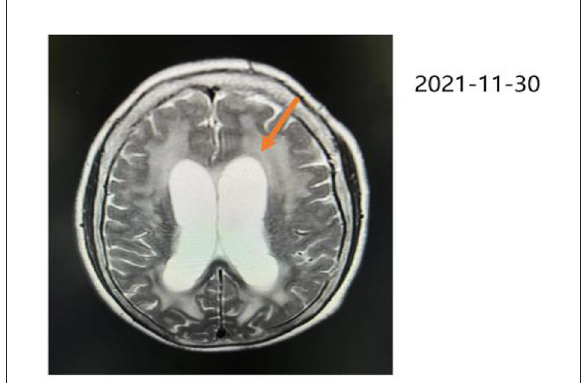
FIGURE1 Brain MRI in T2-weighted sequence, taken on 30 November 2021, revealing hydrocephalus, ischemic changes in the bilateral frontoparietal occipital lobe, age-related brain changes, and ventriculomegaly where indicated by the orange